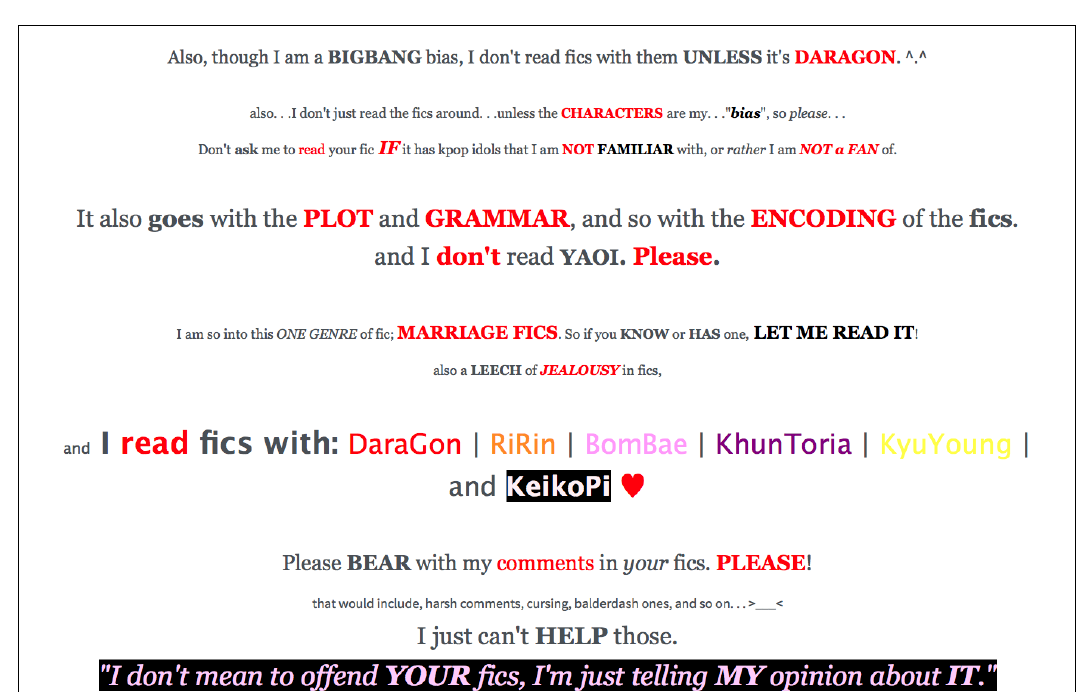
Figure 1. A selected part of a profile page introducing a page owner in